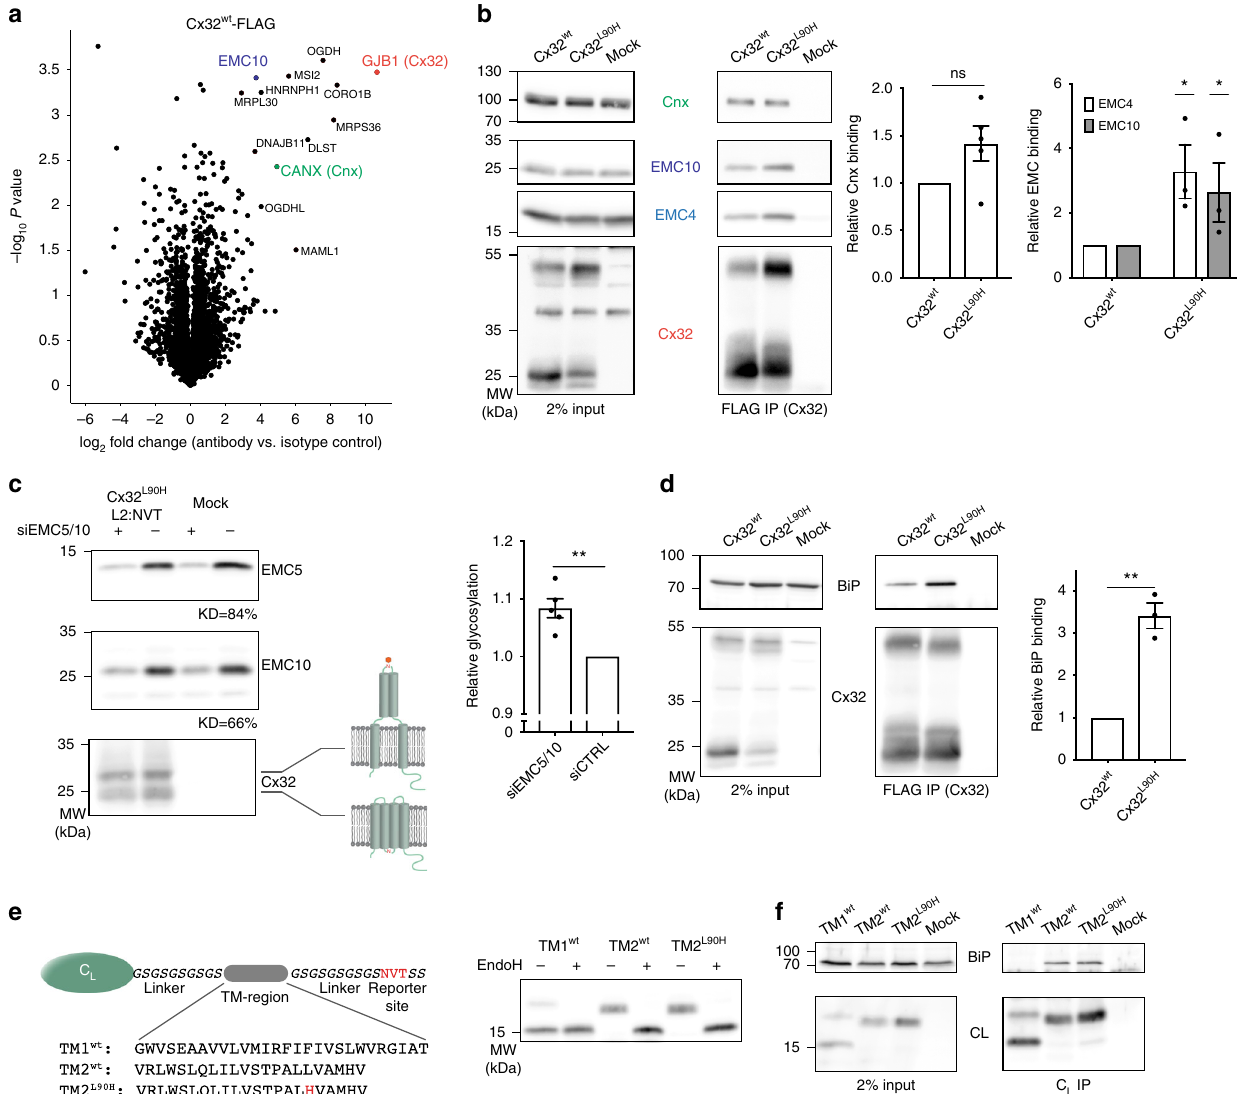
Fig. 3 Connexin mutants are recognized by the ER quality control system. a Mass spectrometry volcano plot for FLAG-tagged Cx32 wt , immunoprecipitated in 1% digitonin from transfected HEK293T cells. Enriched proteins are denoted with their Uniprot gene name. Cx32 is shown in orange and ER chaperones investigated further in this study are highlighted in blue (EMC10) and green (Cnx). Either a rabbit monoclonal anti-FLAG antibody or a rabbit IgG isotype control was used. b Representative blots from immunoprecipitation experiments from HEK293T cells transfected with the indicated Cx32 constructs. Interaction of Cx32 with endogenous Cnx and EMC subunits was detected and increased for Cx32 L90H with both EMC4 and EMC10 (mean ± SEM, N ≥ 3, ns: nonsigni fi cant, * P value < 0.05, two-tailed Student ’ s t tests). Quanti fi cations were performed as described in the Methods section. c